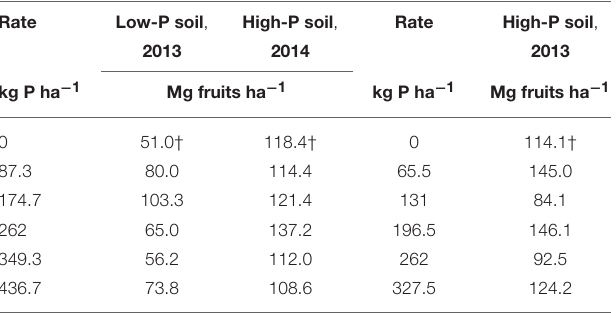
Frontiers in Plant Science |